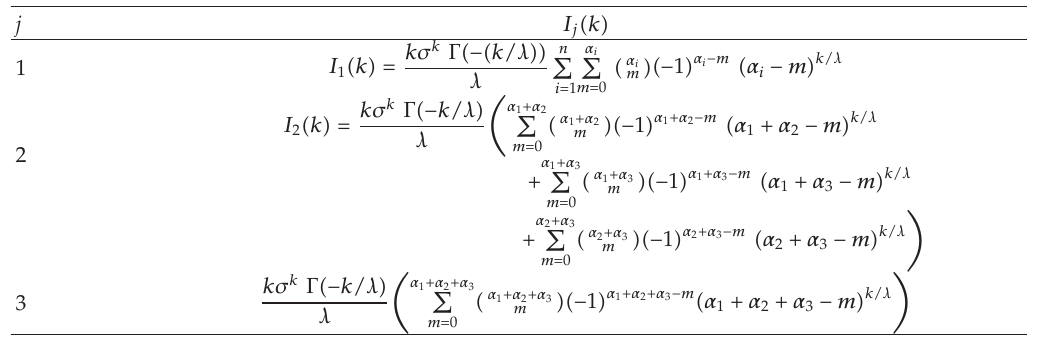
Table 2: I j (cid:2) k (cid:3) using (cid:2) 3.5 (cid:3) when n (cid:6)